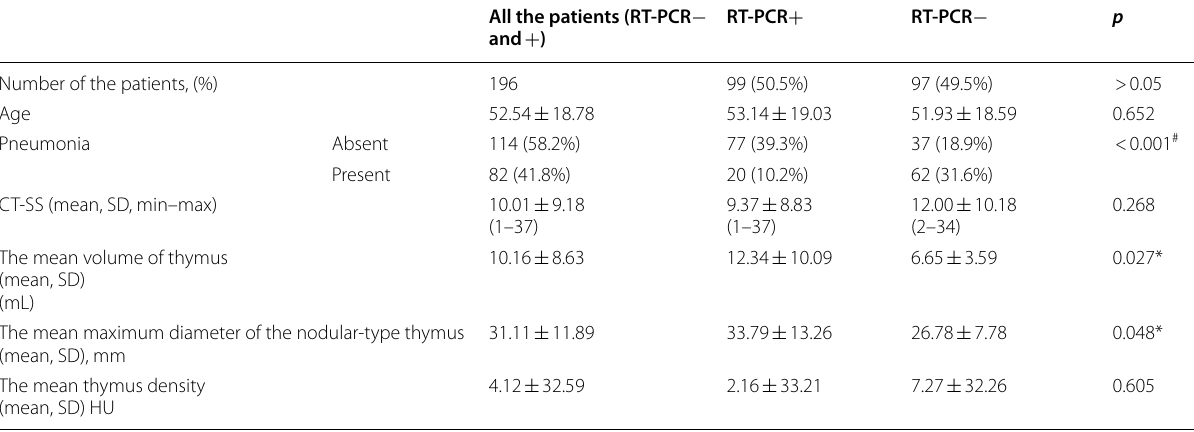
SD standard deviation, HU Hounsfield